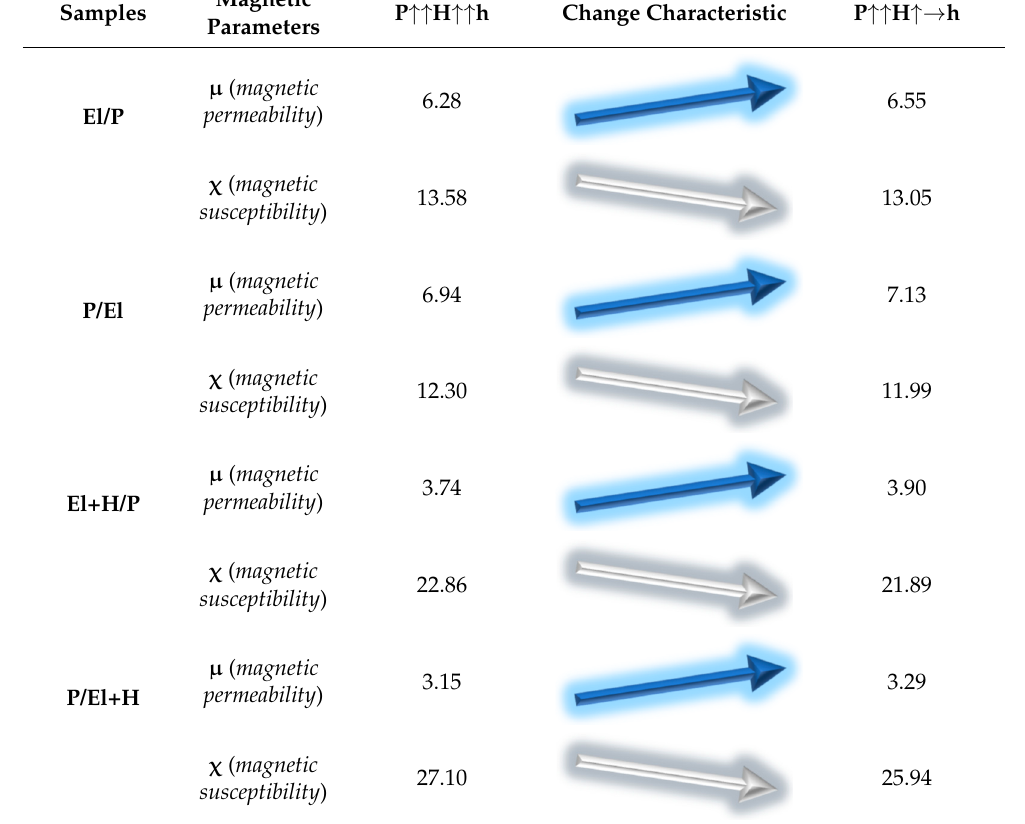
Table 1. Angular values of re fl ections and their intensities. Table 2. Specific magnetic susceptibility and specific magnetization of nickel films depending on the conditions for obtaining samples and the orientation of the magnetic field during measurements.